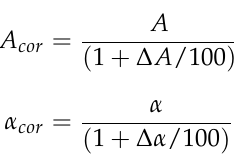
Figure 6. Deviation of α versus the undershoot factor ( ∆ y 2 ) and the fitted curve. The deviations ( ∆ x ) of the base curve parameters ( A , B , α , or β ) are defined as Equation (7), where x cal and x std are the parameters computed by the proposed and standard recommended methods, respectively.